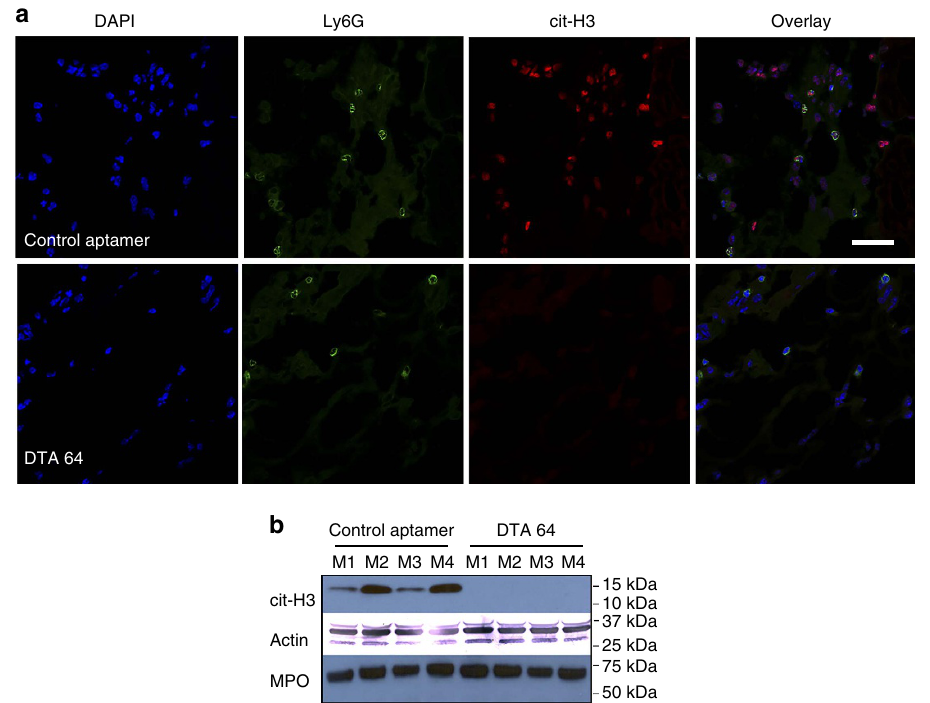
Figure 3 | Anti-DEK aptamers reduce NET formation in zymosan-injected joints. ( a ) Representative confocal microscopy images of permeabilized joint sections from knees injected with zymosan and control aptamer ( n ¼ 3) or anti-DEK aptamer ( n ¼ 3) stained for Ly6-G (green) or the NET marker citrullinated histone H3 (cit–H3) antibody (red). Magnification (cid:3) 60 (scale bar 20 m m). Staining for cit-H3 is undetectable in the neutrophils in the DTA 64-injected knees, but is readily seen in the control aptamer-injected joints. The absence of cit-H3 in the DTA-64 injected-knees correlates with the loss of NETs. (Please note that permeabilization of the cells makes it difficult to detect NETstructures; please see NETstaining in the non-permeabilized section with MPO in Supplementary Fig. 6E.) ( b ) Western blot analysis of knee joint homogenates from eight different mice (four joints/group) confirming dramatic decreases in cit-H3 in joints injected with DTA-64 as compared to control